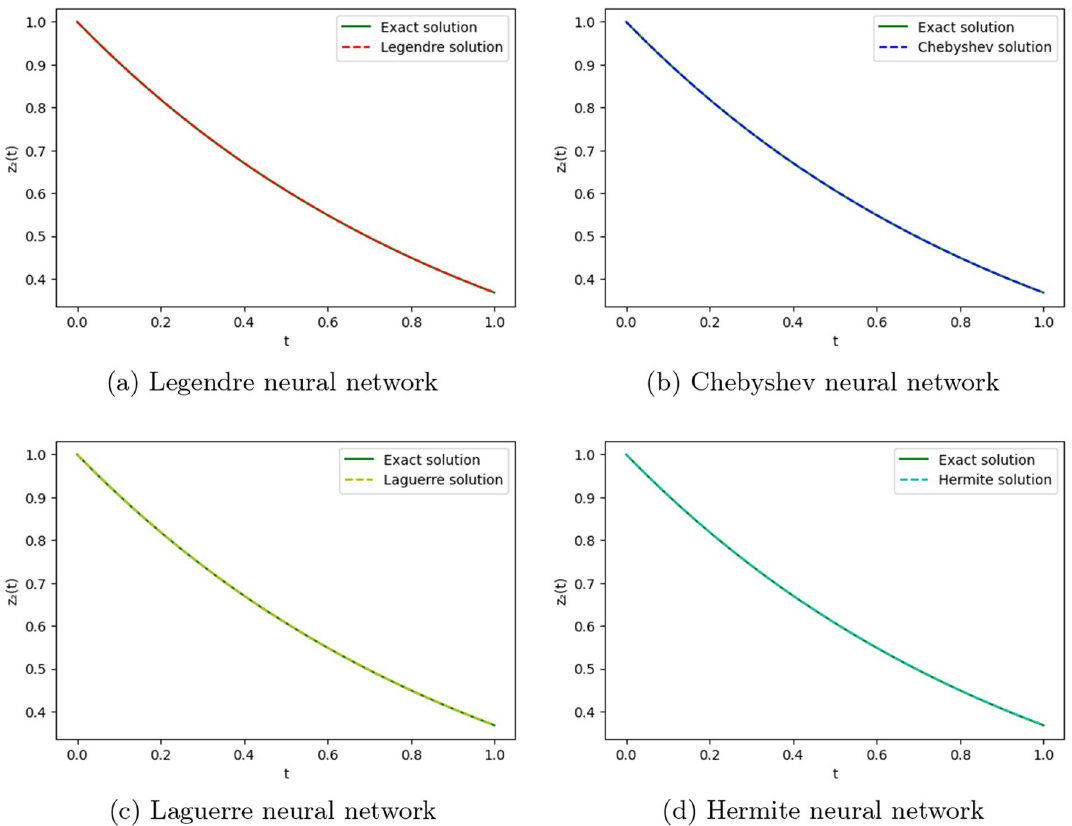
Figure 13. Comparison of the exact solution z 2 ( t ) with the obtained approximate solutions of Example 7.2.